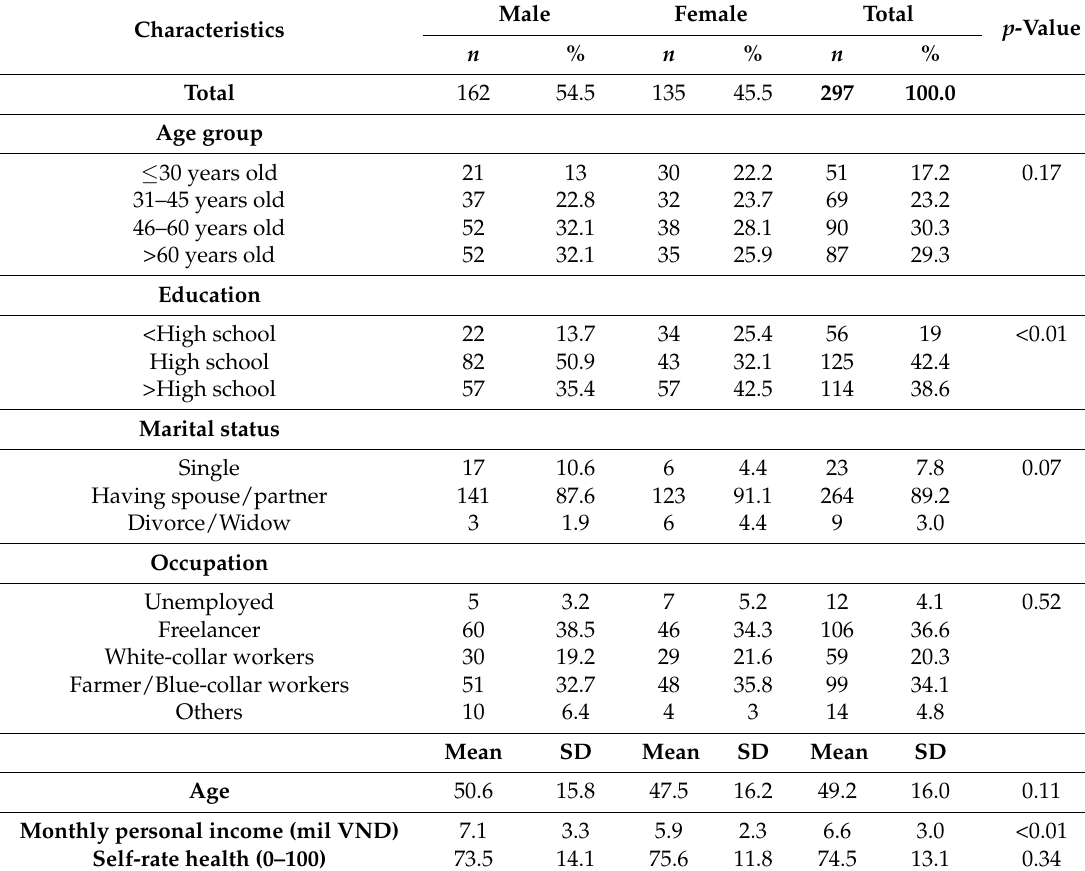
Table 1. Socioeconomic characteristics and self-perceived health status among chronic hepatitis B (CHB)